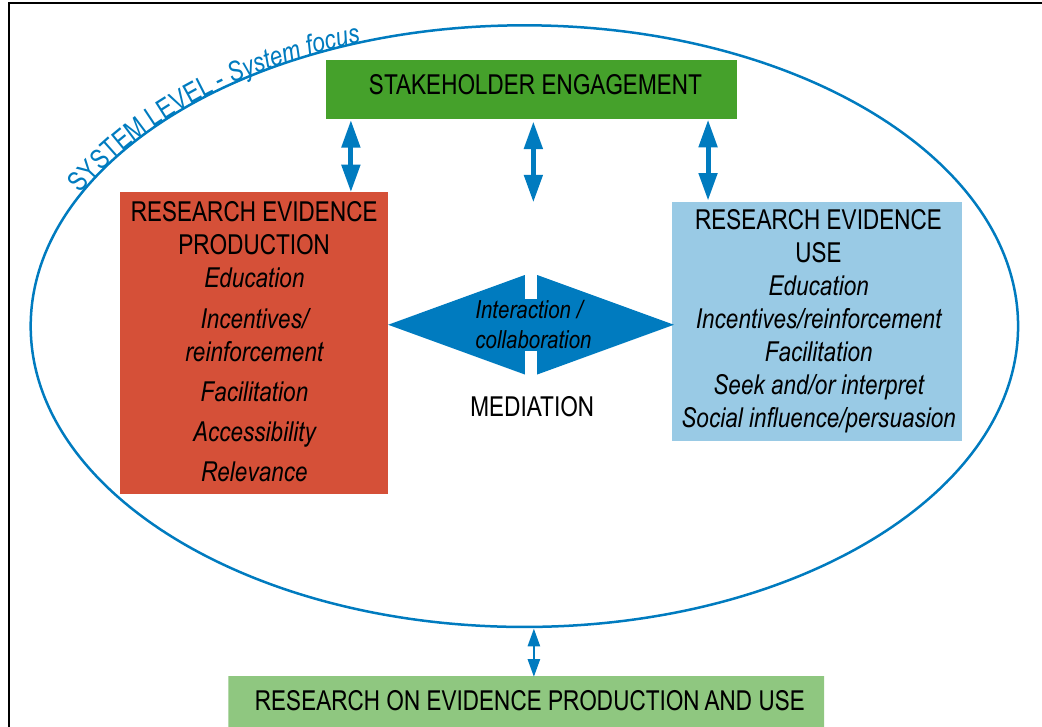
Figure 2: Expected location of the mechanisms within the research evidence production-to-use